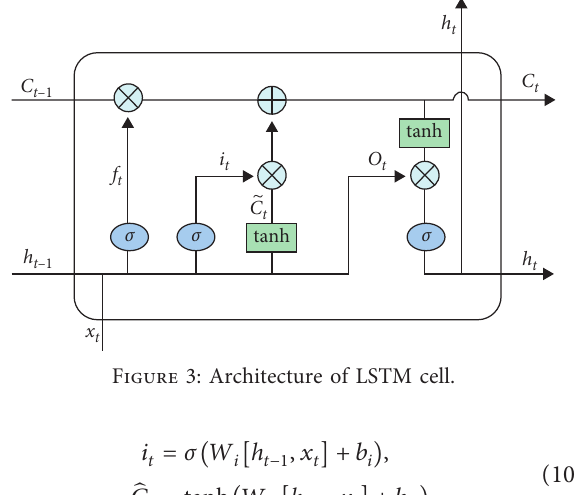
Figure 3: Architecture of LSTM